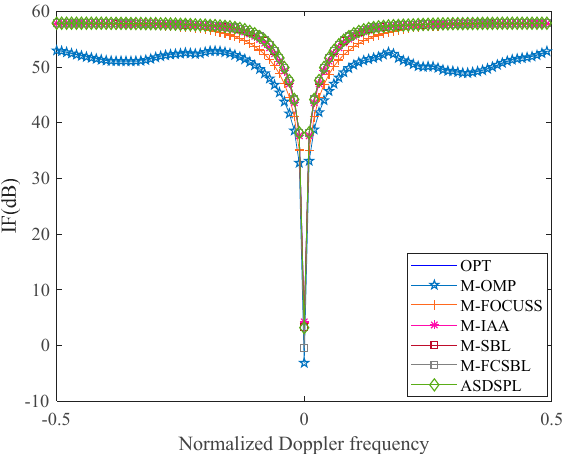
Figure 5. IF curves with the ideal case.